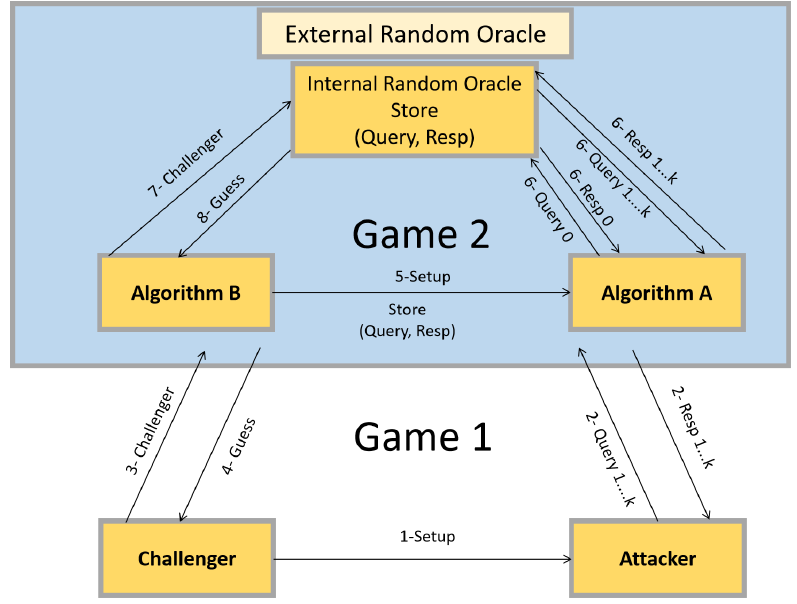
Figure 3. Steps of Random Oracle